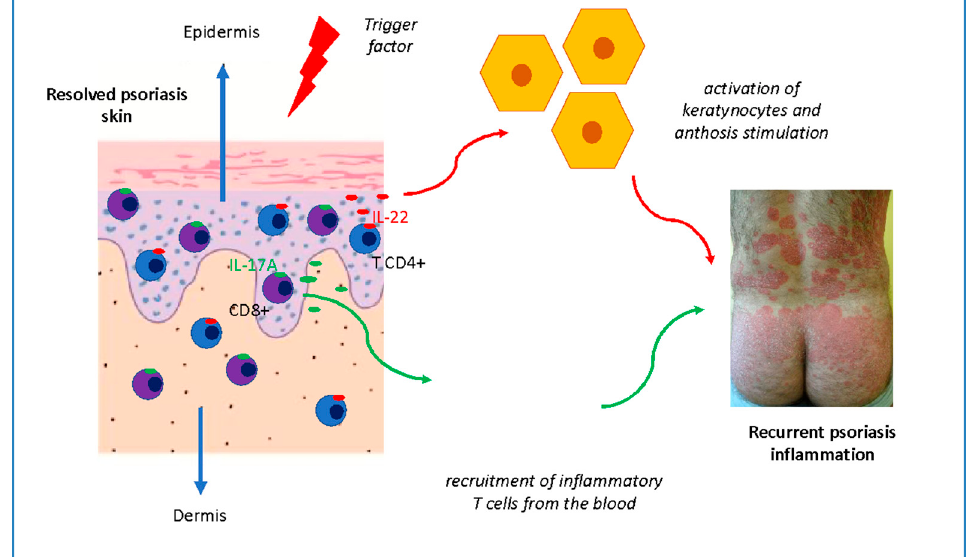
Figure 3. The role of TRM in psoriatic inflammation.